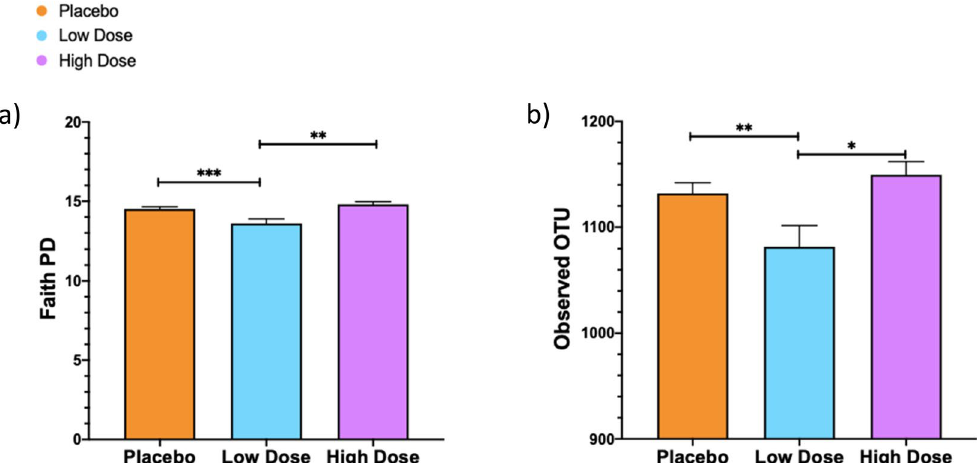
Figure 4. Probiotic administration at a low dose decreases intestinal microbiota diversity. Alpha diversity was determined by Faith PD Whole Tree and Observed OTUs in hamsters treated with a high dose (purple) or low dose (blue) of the probiotic and in placebo-treated hamsters (orange). No differences within groups were observed, thus groups were collapsed across time points. Both Faith PD ( a ) and Observed OTUs ( b ) indicated that hamsters given a low dose of the probiotic (blue) had lower diversity than did hamsters given a high dose (purple) or placebo (orange). *denotes p < 0.05; **denotes p ≤ 0.01; ***denotes p ≤ 0.001. Data presented as mean +/− standard error of the mean.